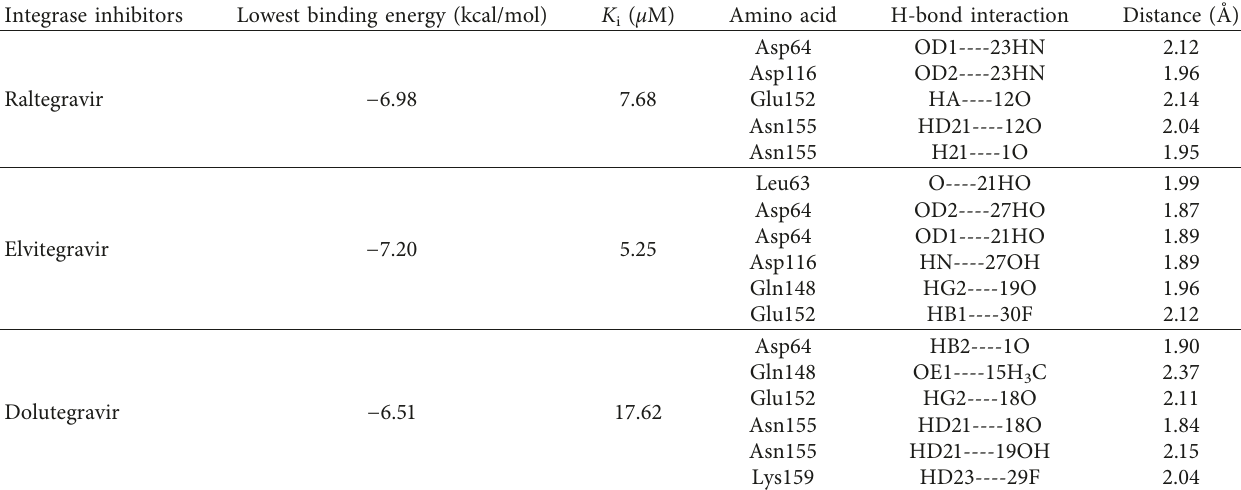
Table 5: Molecular docking study of drugs as HIV-IN